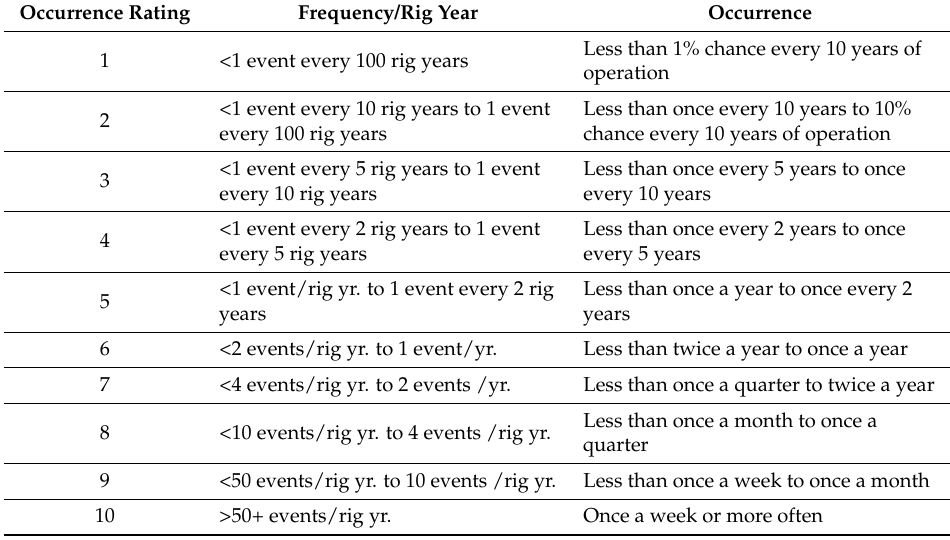
Table 5. Occurrence ratings of a failure for